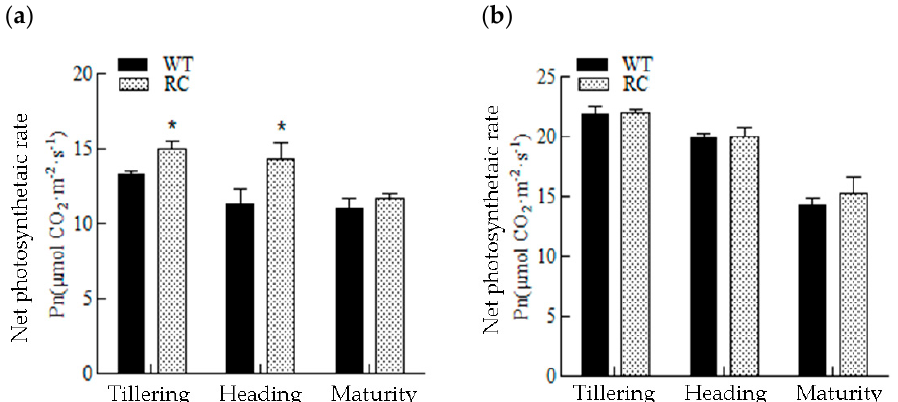
Figure 4. Photosynthetic rate of rice leaves at di ff erent growth stages under di ff erent nitrogen treatments in pots: ( a ) No nitrogen treatment—LN; ( b ) normal nitrogen treatment—NN. * Indicates significant di ff erence ( p < 0.05) between di ff erent samples in the same growth period, calculated by LSD’s test.